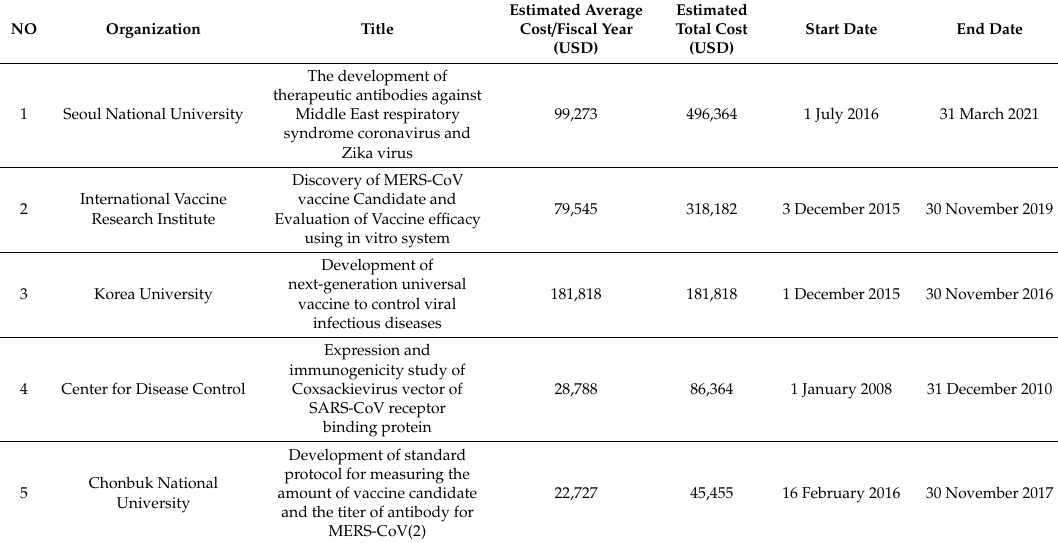
Table 9. Research related to the platform for the immunological response to viral infection and for vaccine development in Korea (Sub-Cluster 1-2).